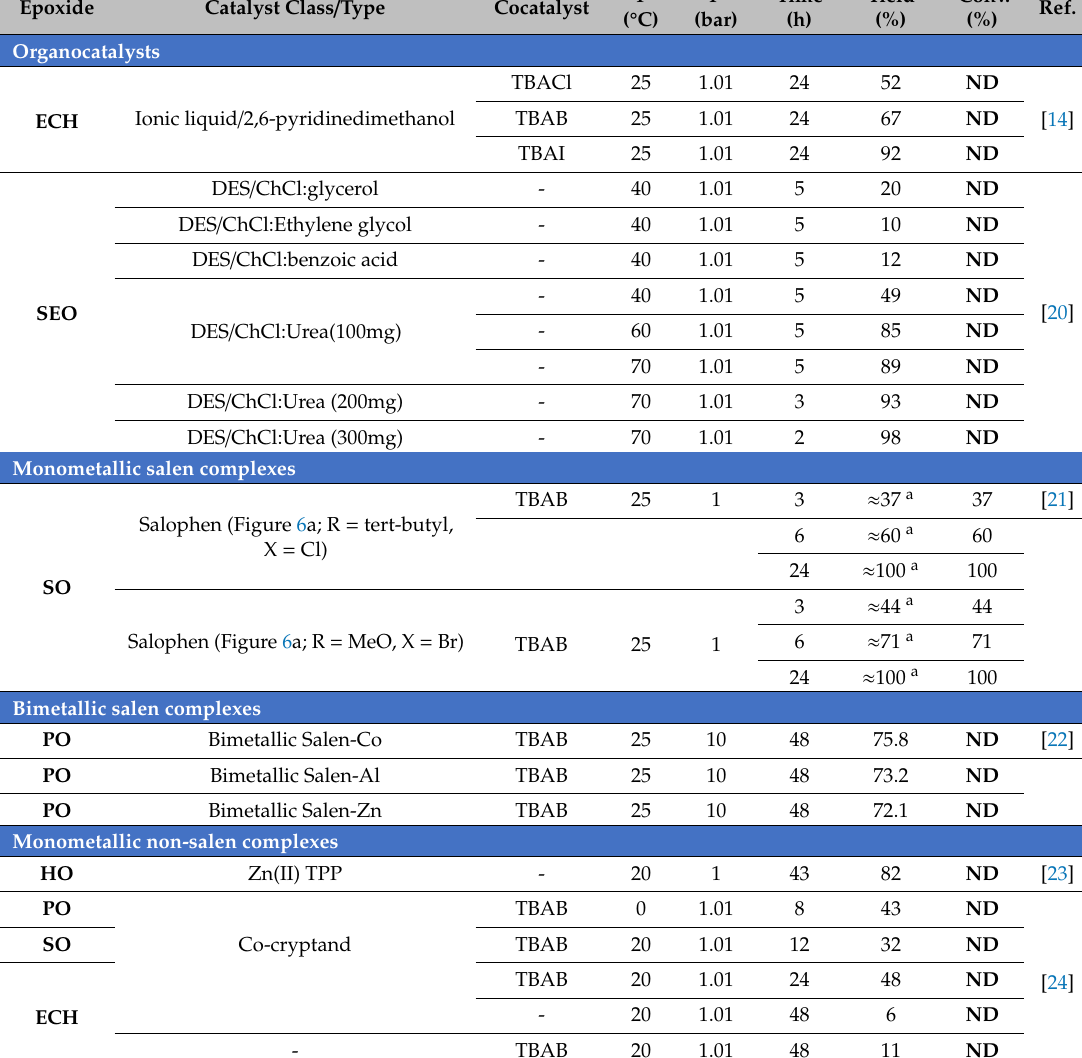
Table 1. Operational conditions and the corresponding outputs from the CO 2 cycloaddition reactions catalyzed by di ff erent homogeneous